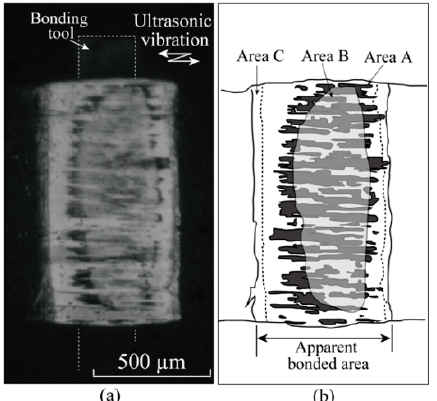
Figure 8. Explanation of Areas A, B, and C by illustrating the video capture at t = 400 ms under F b = 7 N and P u = 4 W: ( a ) Video capture at t = 100 ms; ( b ) Schematic illustration of the video capture.